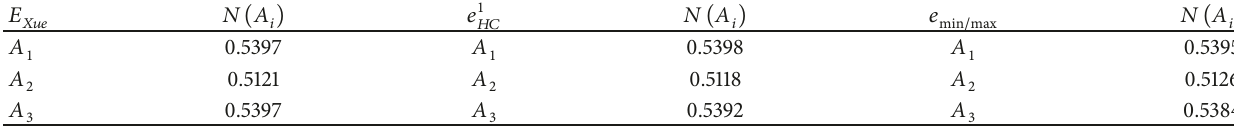
Table 9: Degree of relative closeness.